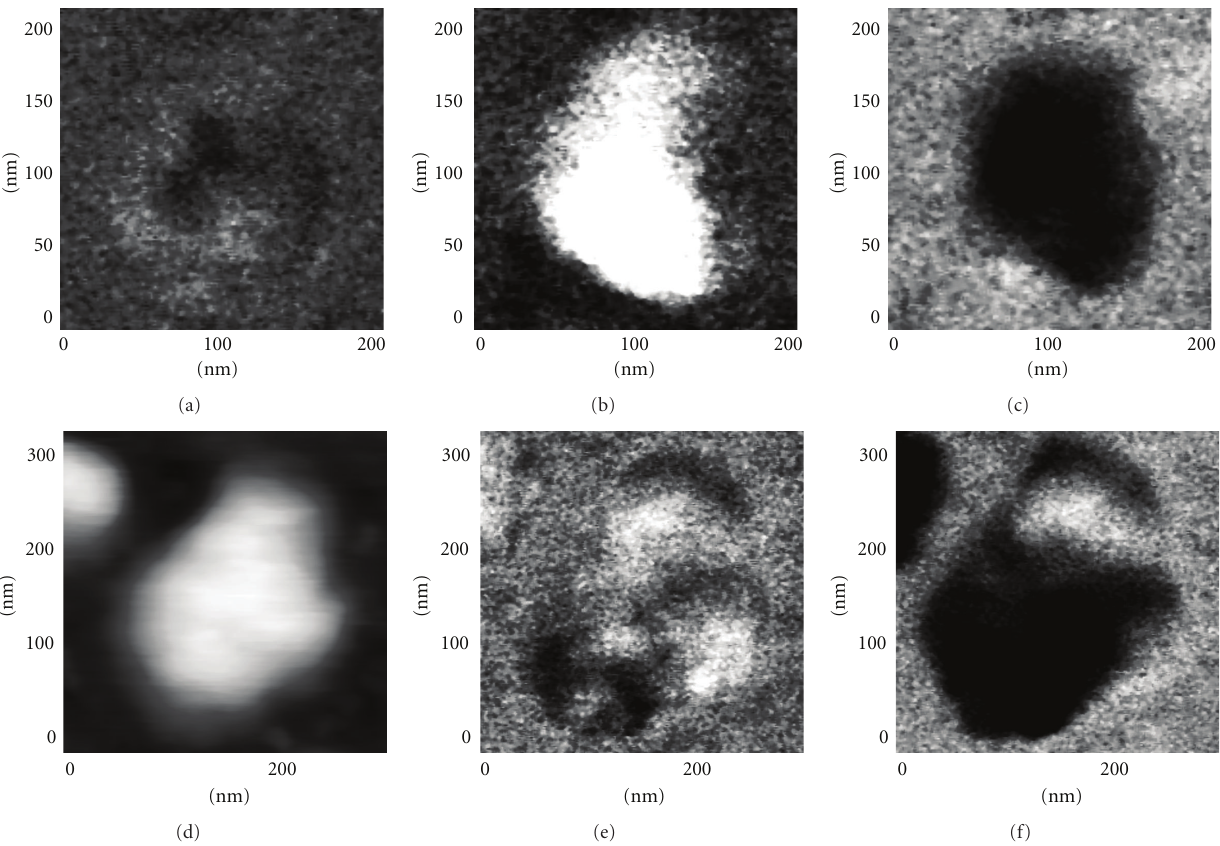
Figure 1: Piezoresponse images of the crystals at the following stages: nanocrystal no. 1 ( R ≈ 50 nm, h ≈ 15nm) (a) initial phase image, (b) after applying a bias voltage +10V, and (c) after applying a bias voltage − 10 V; nanocrystal no. 21 ( R ≈ 100 nm, h ≈ 25 nm) (d) topography, (e) initial phase image, and (f) after applying a bias voltage − 10 V. activation field E a = 1, 4 GV/m, a little larger than the value 1 GV/m obtained with thin-film capacitors of a similar 73 : 27 composition copolymer